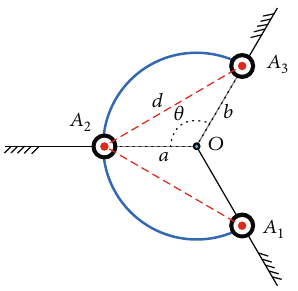
Figure 2: The schematic of the spatial multi-loop over-constrained mechanism.